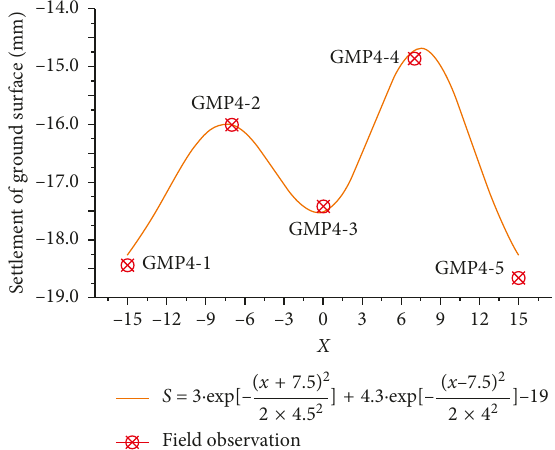
Figure 20: Calculation results and settlement value of GMP4-1 ∼ 5.